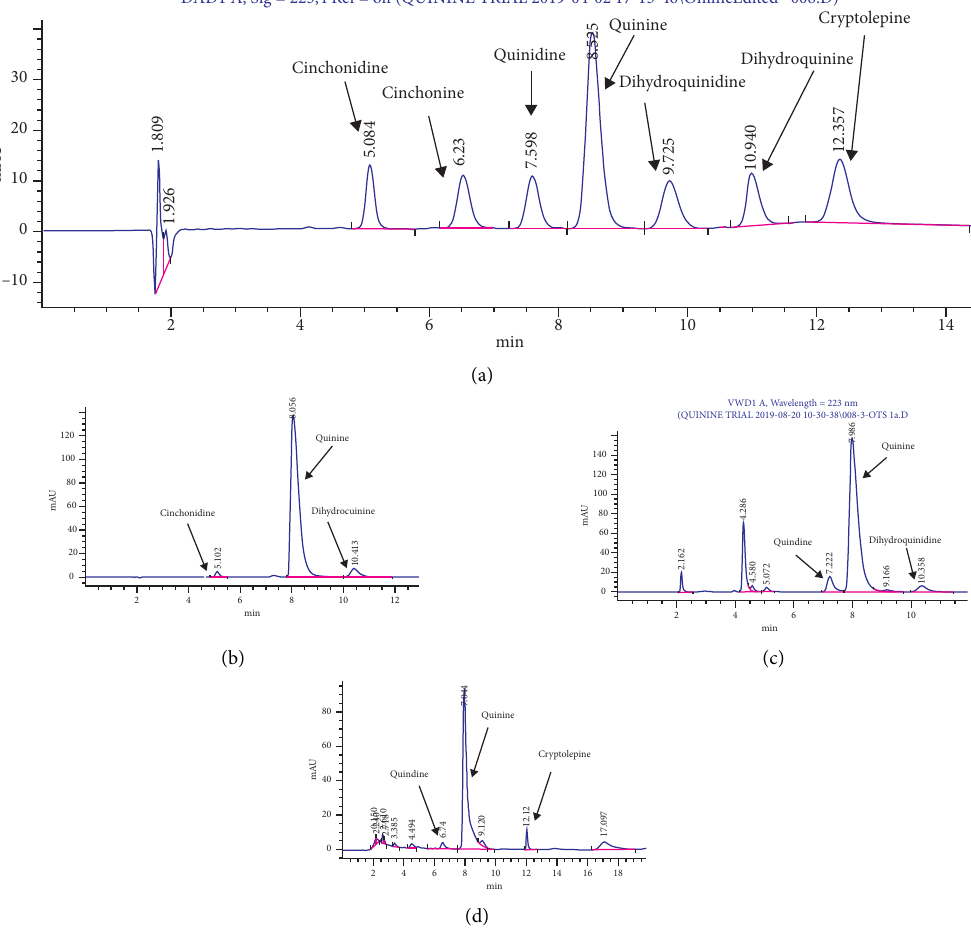
Figure 1: HPLC chromatograms of reference standards and samples using the developed method. (a) Chromatogram showing the optimum separation of the reference standards, namely, cinchonidine, cinchonine, quinidine, quinine, dihydroquinidine, dihydroquinine, and cryptolepine using the developed method. (b) Chromatogram showing the presence of quinine, cinchonidine, and dihydroquinine in an API sample. (c) Chromatogram showing the presence of quinine, quinidine, and dihydroquinidine in a QBPAF. (d) Chromatogram showing the presence of quinine, quinidine, and cryptolepine in a